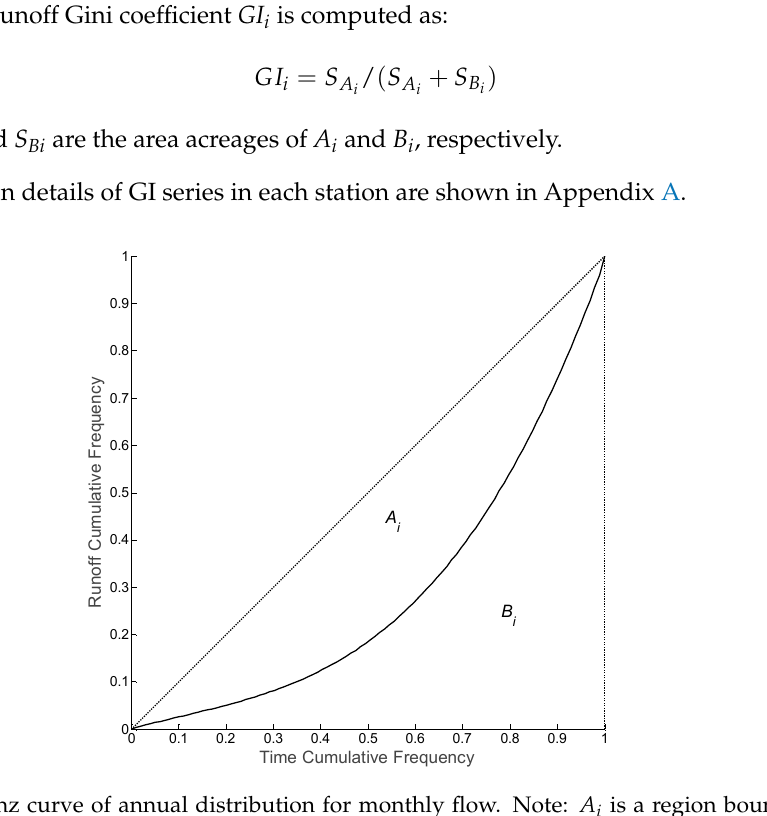
Figure 3. Lorenz curve of annual distribution for monthly flow. Note: A i is a region bounded by Lorenz curve and dashed diagonal, B i is a region bounded by Lorenz curve and vertical diagonal.